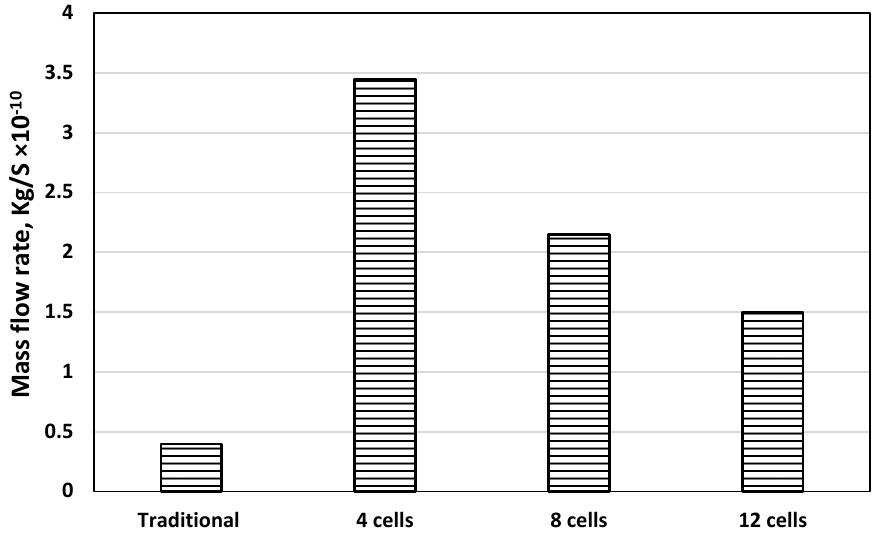
Figure 11. The mass flow rate of water vapor at the exit for different designs.